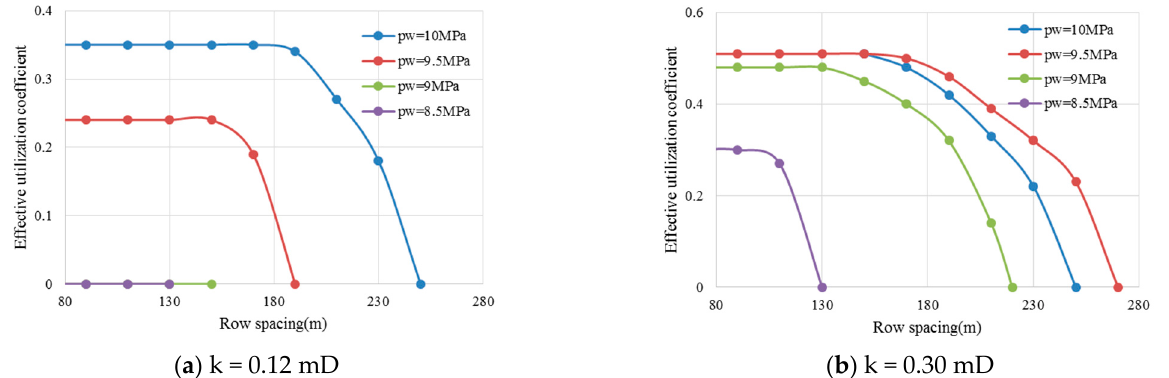
Figure 23. The relationship between the effective utilization coefficient and the row spacing.